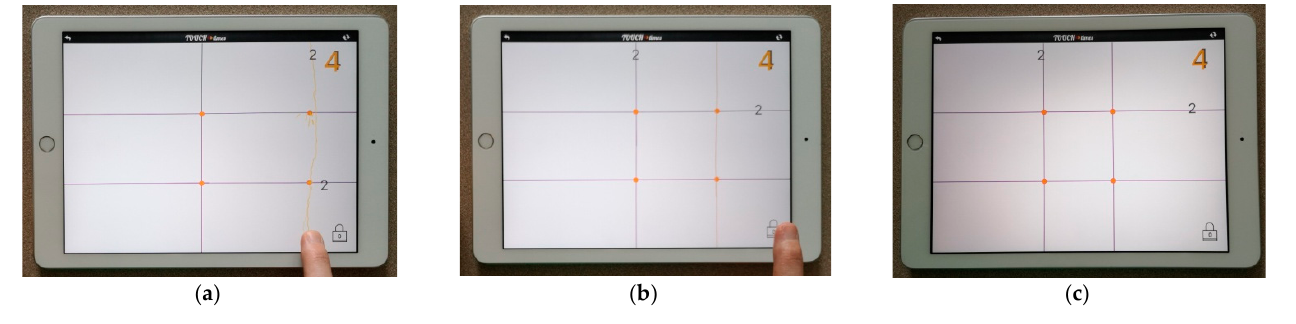
Figure 7. ( a – c ): Adding a vertical line in locked mode.